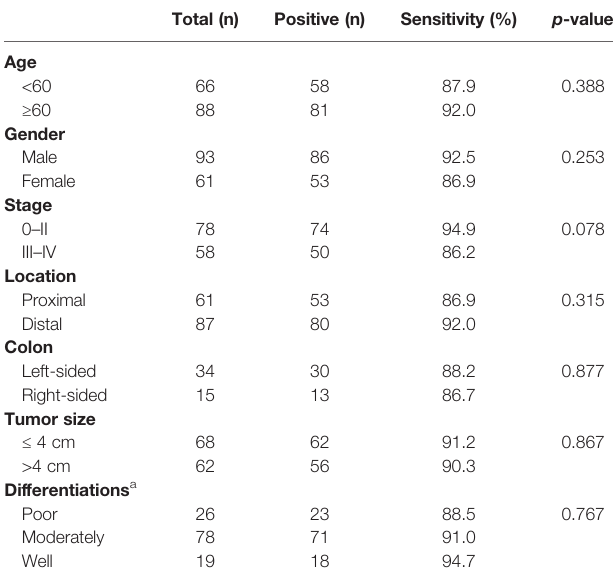
FIGURE 4 | ROC curves for stool m CLIP4 test for detecting AA (A) and CRC (B) . AUC values for AA (A) and CRC (B) were 0.892 (95% CI: 0.795 – 0.988) and 0.961 (95% CI: 0.938 – 0.983), respectively. TABLE 4 | Sensitivities of stool m CLIP4 test for detecting CRC for different age groups, genders, stages, tumor locations, sides, tumor sizes and differentiation